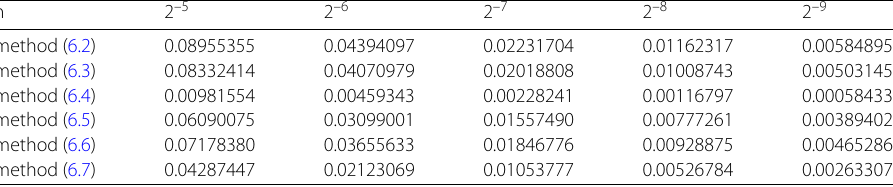
Table 4 The endpoint average sample errors of method (6.2)–(6.7) for solving